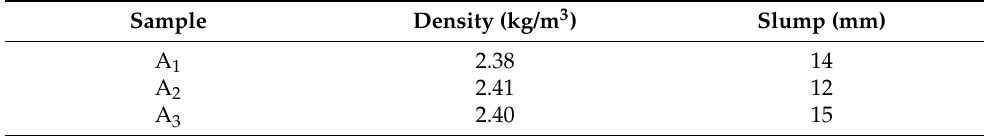
Table 6. Physical properties of concrete.